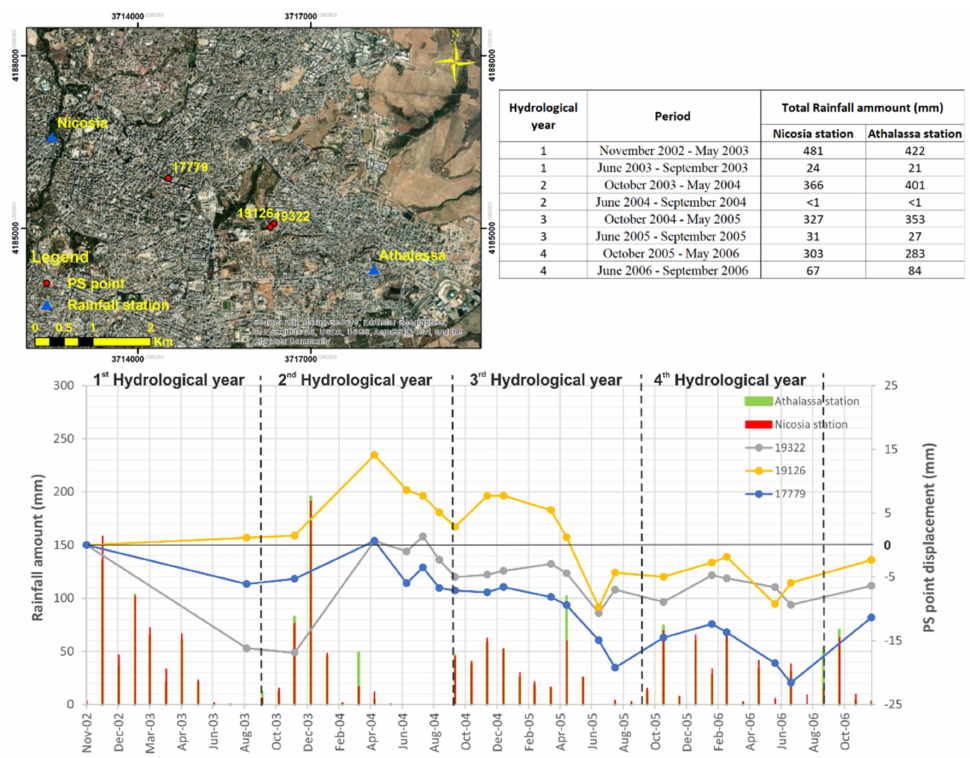
Figure 8. Times series of displacement (right axis) and rainfall (left axis) for three characteristic PS